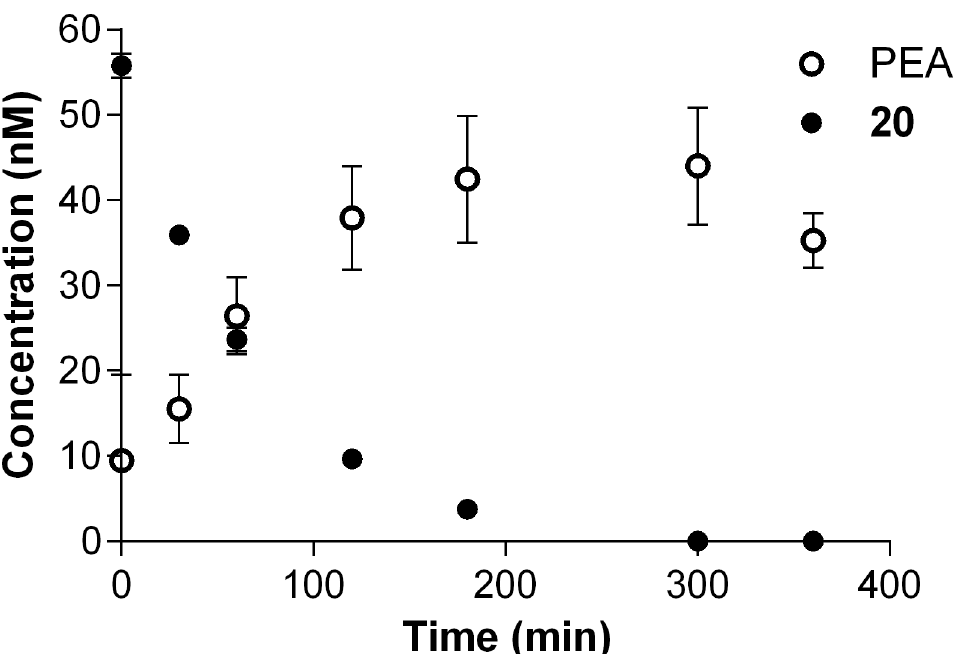
Fig 7. L-Val-PEA (20) biotransformation and PEA release in rat plasma. Time course of L-Val-PEA (20, ● ) hydrolysis in 80% v/v rat plasma and corresponding release of PEA (1, (cid:2)